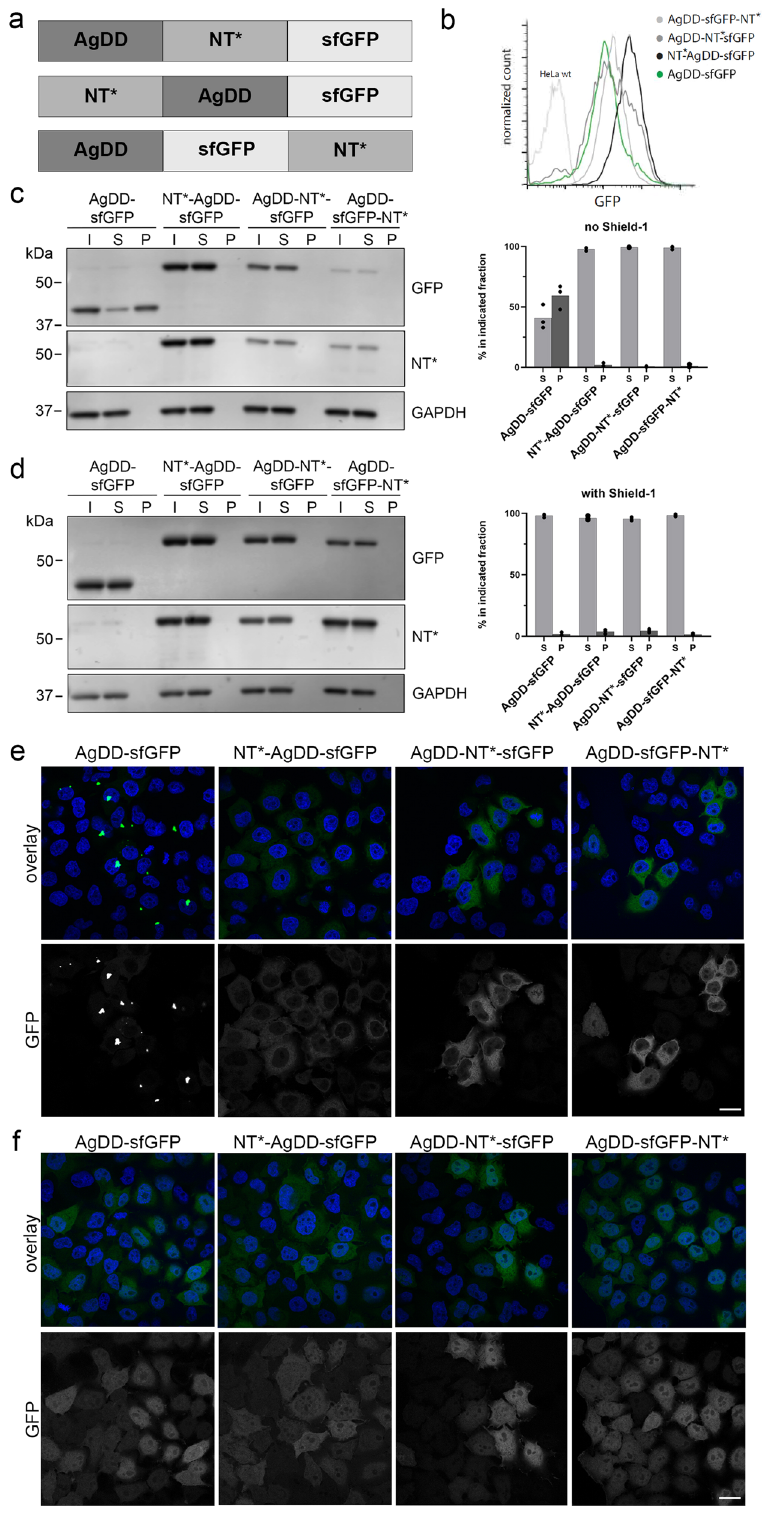
Fig. 2 Anti-aggregation effect of NT* is independent of its position within the host protein. a Schematic representation of the fusion proteins with the NT* domain in different positions. b HeLa cells were stably transfected with the fusion proteins depicted in (A) and analysed by fl ow cytometry. c , d HeLa cells stably expressing AgDD-sfGFP, NT*-AgDD-sfGFP, AgDD-NT*-sfGFP or AgDD-sfGFP-NT* were incubated for 16 – 24 h in the absence ( c ) or presence of 1 µ M Shield-1 ( d ) and fractionated into Triton X-100 soluble (S) and Triton X-100 insoluble/SDS soluble (P) fractions. Input of whole cell lysates before fractionation are shown (I). Western blots were performed with antibodies directed against GFP, the NT*-tag and GAPDH. Quanti fi cations of the relative distribution of the GFP band in the soluble and insoluble fractions from three independent experiments are shown ( e , f ). HeLa cells stably expressing AgDD-sfGFP, NT*-AgDD-sfGFP, AgDD-NT*-sfGFP or AgDD-sfGFP-NT* in the absence ( e ) or presence ( f ) of 1 µ M Shield-1 were fi xed in 4% PFA and counterstained with Hoechst. Scale bar is 20 µ